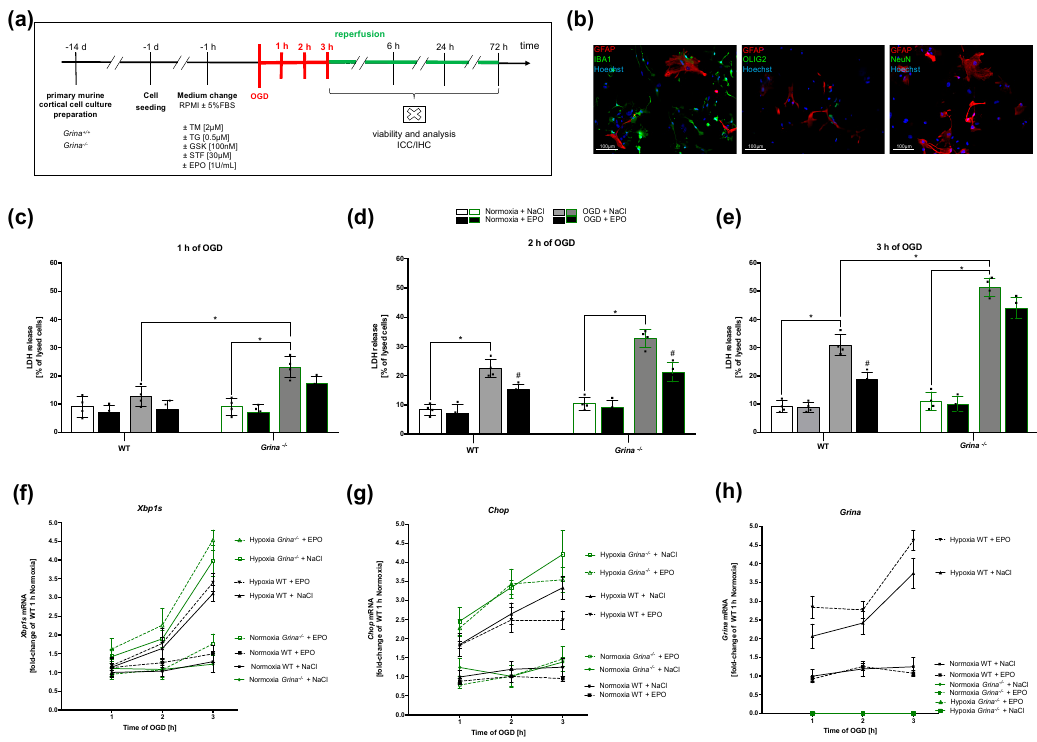
Figure 5. OGD for 3 h induced high rates of apoptosis and activated the IRE1 α and PERK arm of UPR ( a ) Experimental design of OGD with primary murine cortical mixed cell culture. OGD was performed for either 1, 2 or 3 h followed by a reperfusion of 1, 6, 24 and 72 h. Prior to OGD / normoxia ( − 1 h), administration of TM (2 µ g / mL), TG (0.5 µ M), GSK (100 nM), STF (30 µ M) and treatment with EPO [1 U / mL] or corresponding controls (NaCl / DMSO) was performed. ( b ) Representative images of immunofluorescence staining using anti-GFAP antibody to stain astrocytes (red), anti-IBA1 for microglia staining (green), anti-OLIG2 for oligodendrocyte staining (green) and anti-NeuN antibody for staining neurons (green). DNA staining was performed using Hoechst (blue). Primary murine cortical mixed cell culture contained astroytes, microglia and oligodendrocytes but no neurons. LDH release in Grina -/- and wildtype littermate primary murine cortical cells was determined after 1 h ( c ), 2 h ( d ), 3 h ( e ). The mRNA levels of Xbp1s ( f ), Chop ( g ) and Grina ( h ) after 1, 2 and 3 h of OGD are shown. Bars represent means ± SD. n = 4 individual cell culture preperations from mice pups (P0-P2) of all genotypes and treatment groups. * p < 0.05 intergroup comparison, # p < 0.05 EPO treatment compared to the vehicle group.